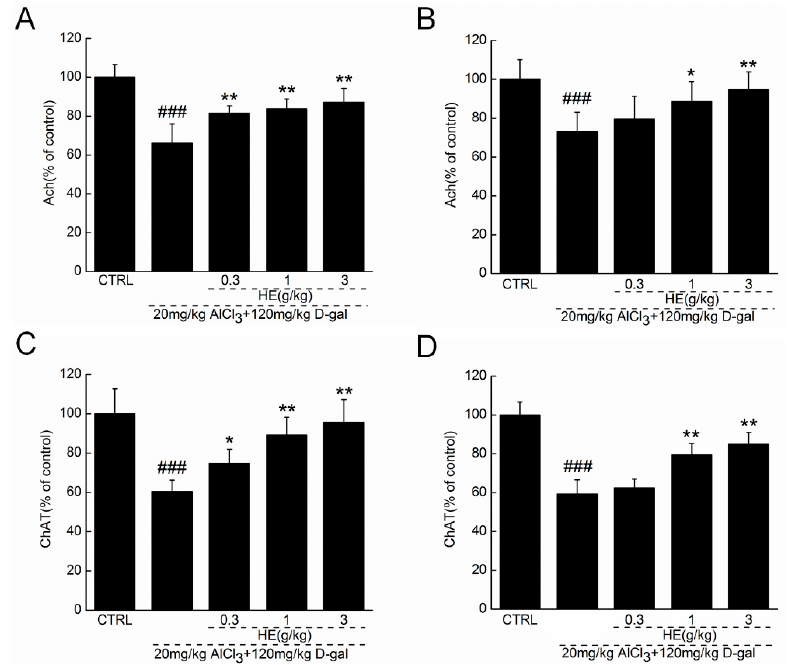
Figure 5. HE treated AlCl 3 - and D -gal-induced AD mice for four weeks, and blood and hypothalamus were collected. The levels of ( A ) acetylcholine (Ach) and ( C ) choline acetyltransferase (ChAT) in hypothalamus, and the levels of ( B ) Ach and ( D ) ChAT in serum were detected via ELISA method. Data are expressed as the percentage to controls and mean ± SD ( n = 10). ### p < 0.001 vs. normal mice (CTRL), * p <0.05 and ** p < 0.01 vs. AD mice. HE: Hericium erinaceus aqueous extract.